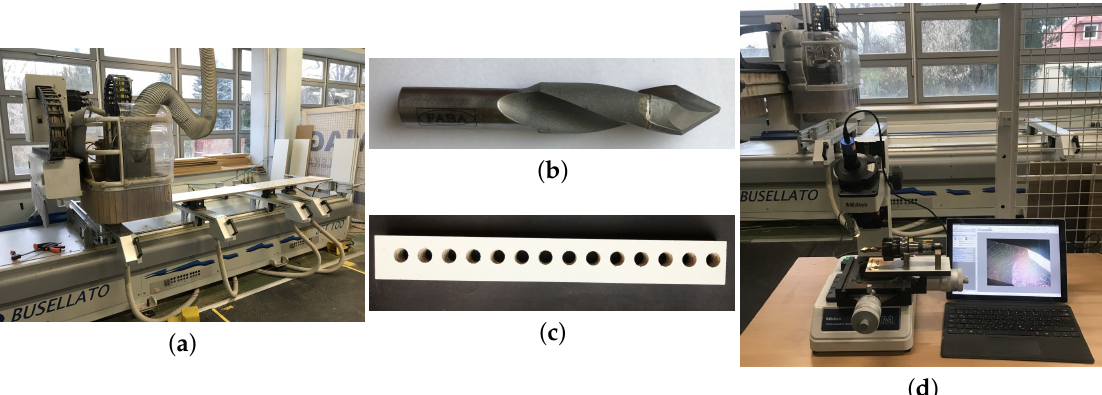
Figure 1. Equipment setup used during the experiments:Busellato Jet 100 machine centre ( a ), 12 mm Faba WP-01 drill ( b ), Kronopol U 511 SM melamine-faced chipboard sample ( c ) and workshop microscope TM–505, Mitutoyo ( d